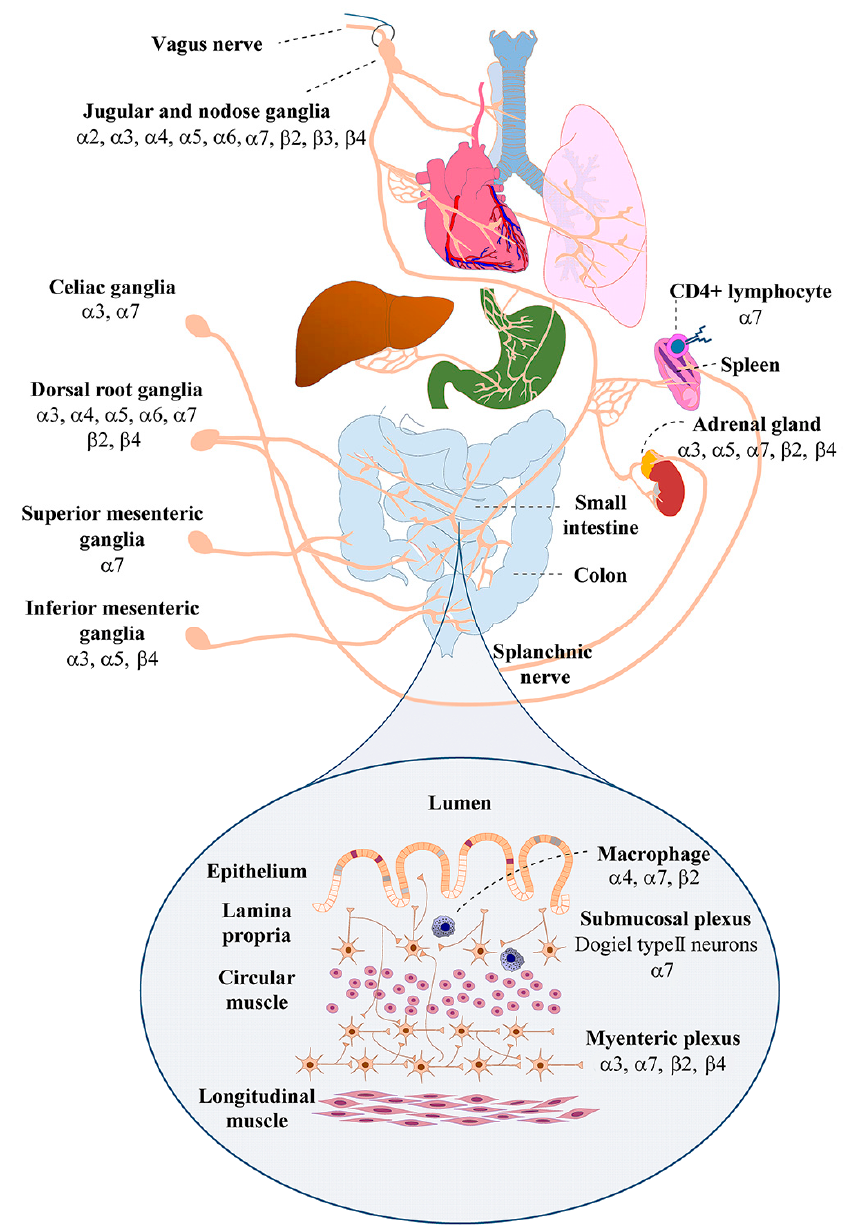
Figure 1. Cartoon representation depicting organs and structures of the gastrointestinal tract and the neurons that innervate them that express nAChR subunits. The inset in the lower part of the cartoon details the structures of the intestines; the myenteric and submucosal plexuses are shown along with select cell types.